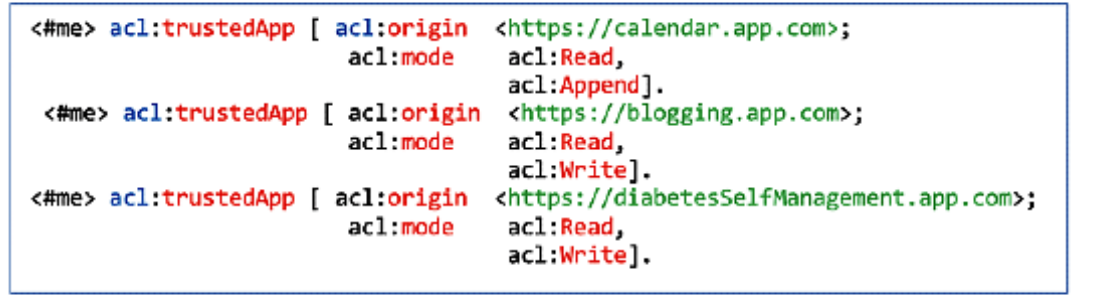
Figure 8. Bob’s trusted